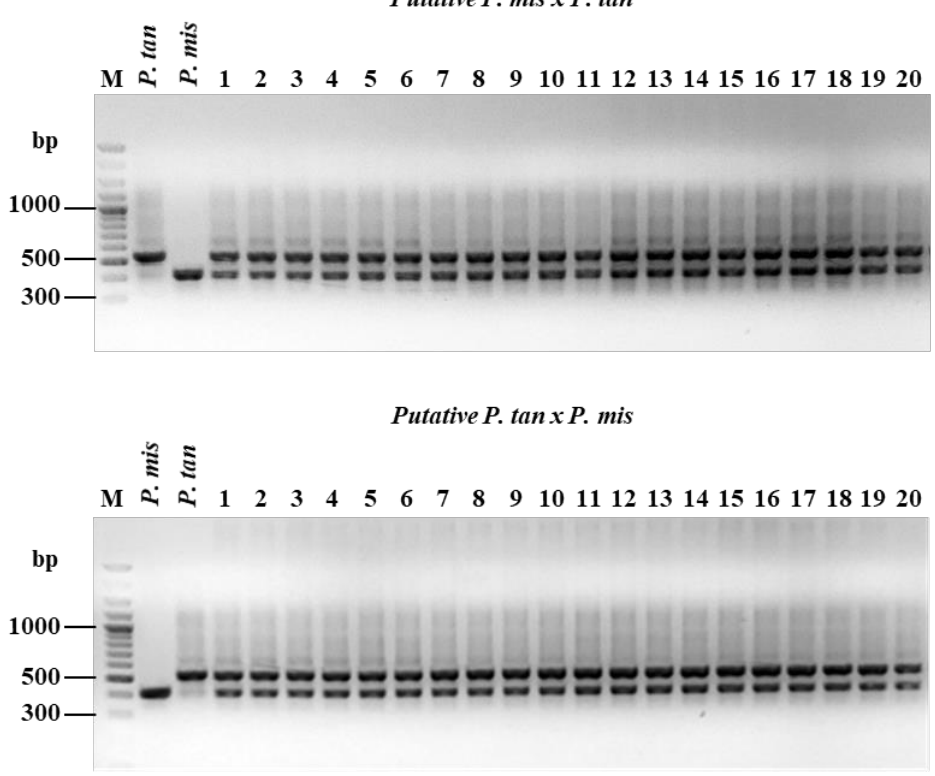
Figure 4. Confirmation of interspecific hybrid by PCR using SCAR primers designed for differenti- ation of P . mishmensis and P . tankervilliae